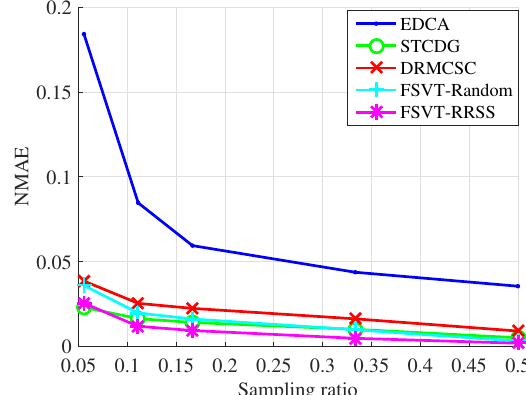
Figure 7. NMAE over sampling ratio for the temperature from Data-Sensing